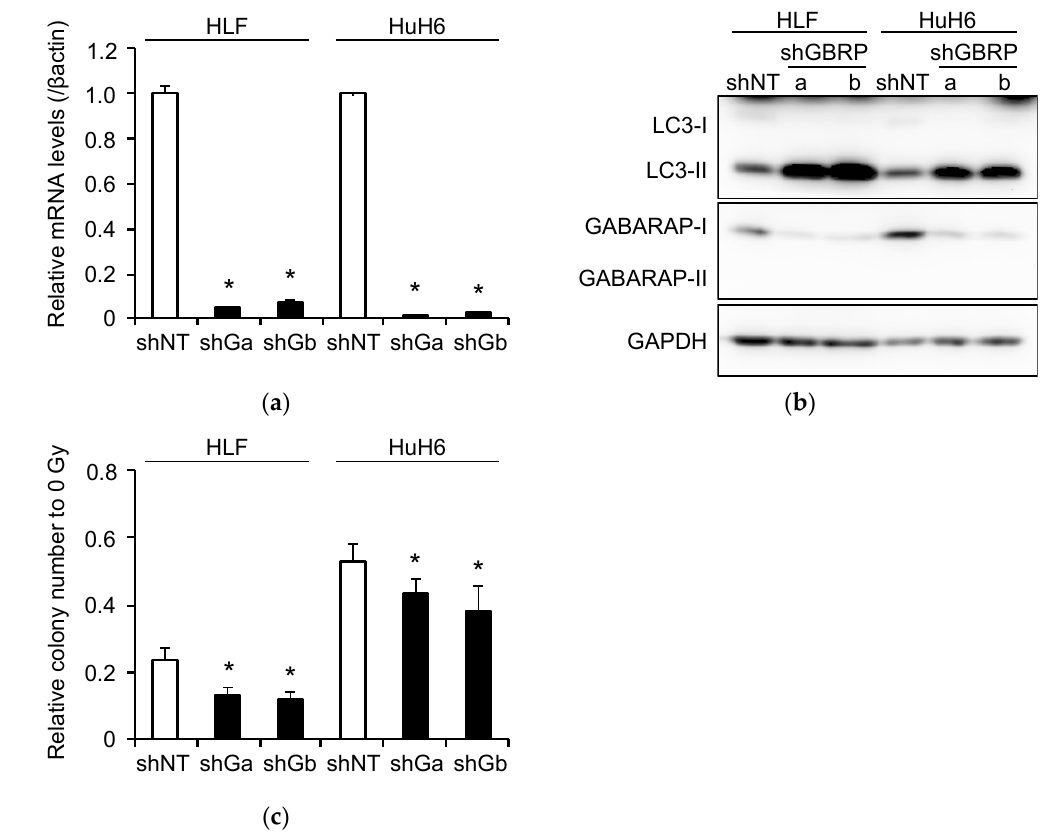
Figure 5. Radiosensitization and autophagy inhibition induced by GABARAP knockdown in HCC cell lines. ( a ) GABARAP mRNA expression levels in HLF and HuH6 cells transduced with shNT or GABARAP ‐ targeting shRNAs (shGa and shGb) for 48 h. * p < 0.05 vs. shNT; Dunnett’s test ( n = 3). ( b ) LC3 and GABARAP protein expression in HLF and HuH6 cells transduced with shNT or GABARAP ‐ targeting shRNAs (shGBRPa and shGBRPb) for 48 h. ( c ) Clonogenicity of HLF and HuH6 overexpressing NEAT1v1 after X ‐ ray irradiation. Following irradiation, the cells were immediately transduced with shNT, shGa, or shGb. * p < 0.05 vs. shNT; Dunnett’s test ( n = 4).